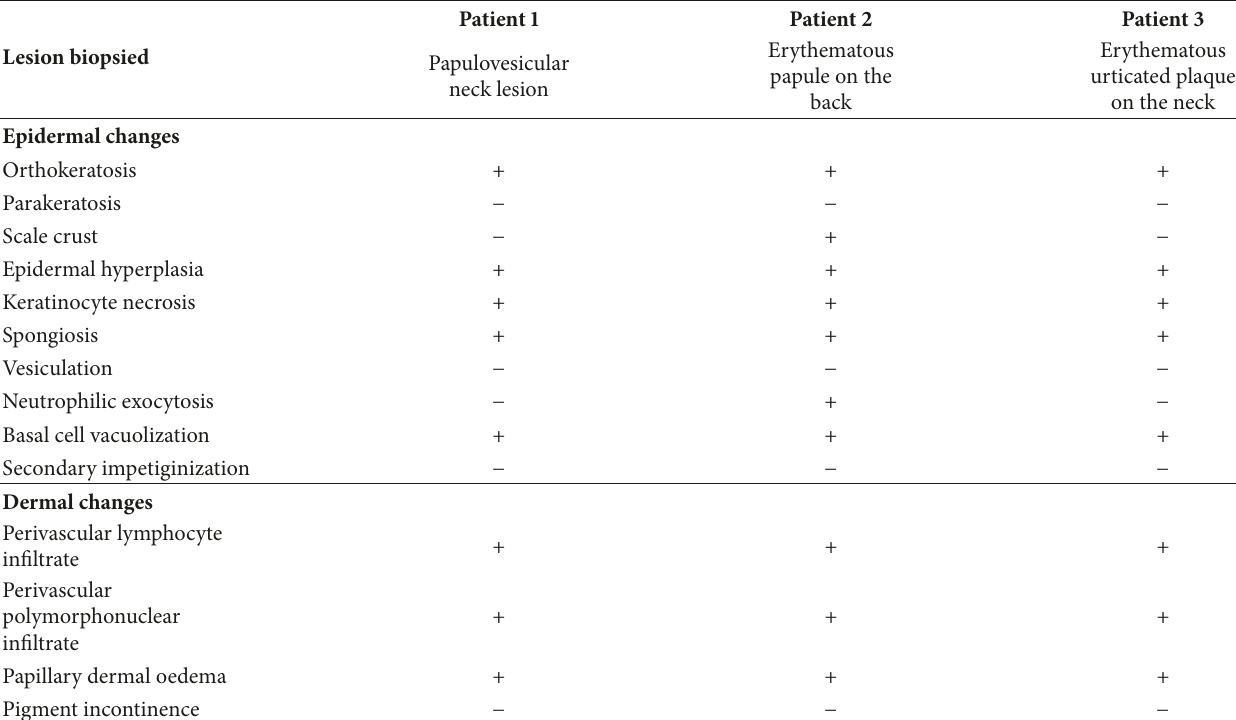
Table 2: The main histologic findings in 3 Jordanian patients with prurigo